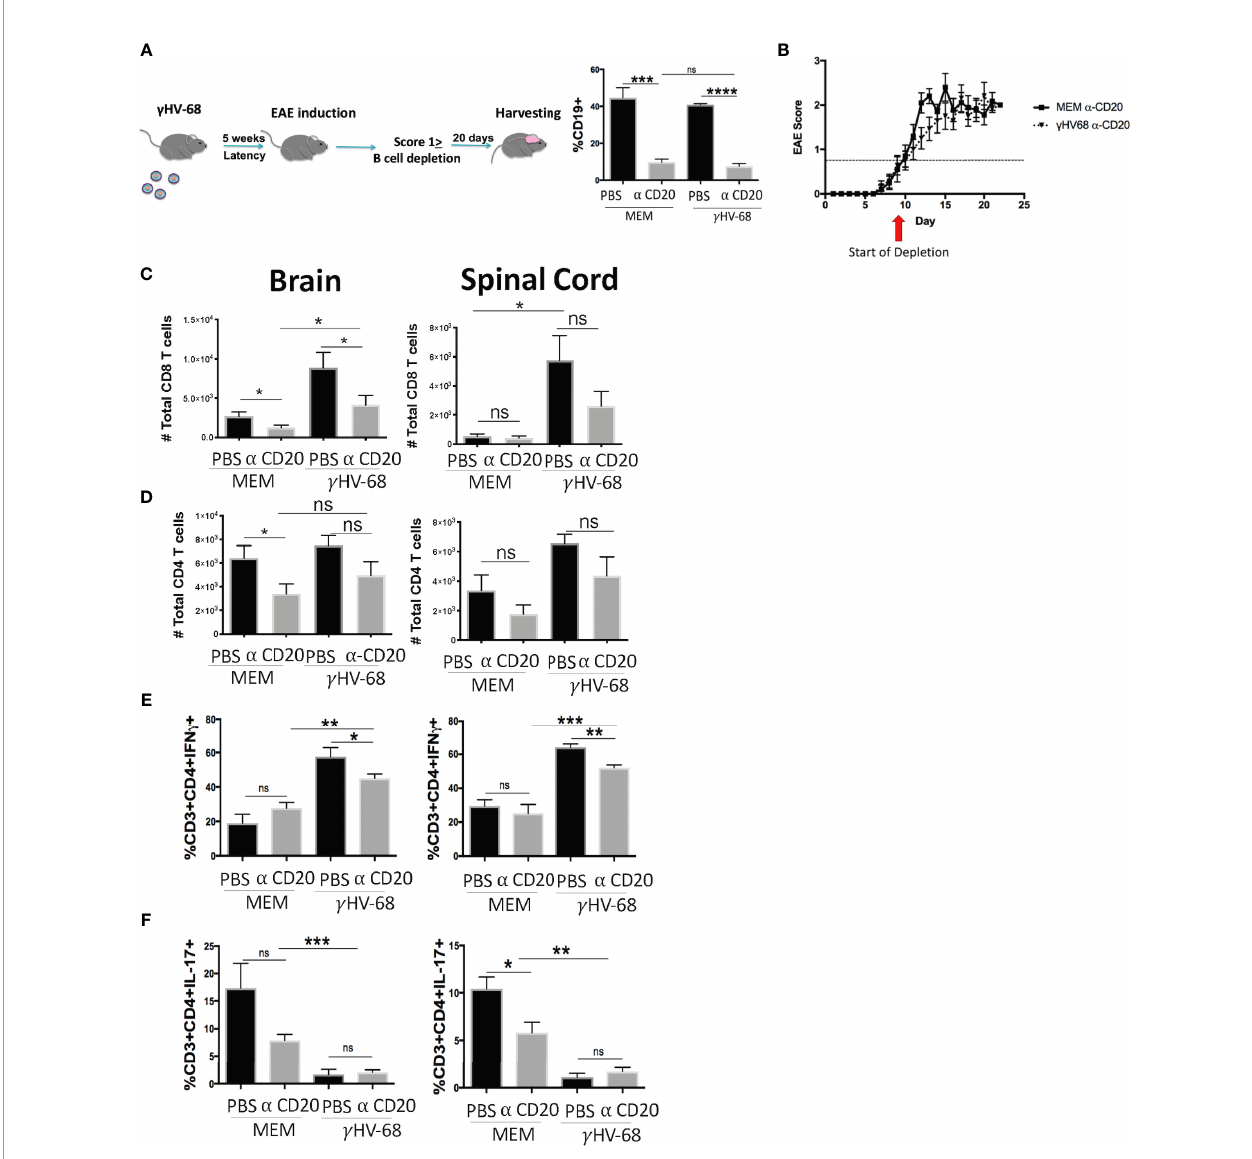
FIGURE 2 | Mice were infected with g HV-68 or MEM i.p. 5 weeks p.i. EAE was induced. When mice reached a score of ≥ 1 B cells were depleted with a -CD20 i.v. At days 20 to 22 post EAE induction, mice were perfused; brains, spinal cords were harvested and processed to isolate immune in fi ltrates. (A) B cell depletion work fl ow. Histogram shows a representative experiment of B population at moment of harvesting. (B) Graph shows EAE scores up to day 23 post induction. (C) Total CD8 + in fi ltrating cells in the brain and spinal cord. (D) Total CD4 + in fi ltrating cells in the brain and spinal cord. (E) Percentage of CD3 + CD4 + IFN g + . ( F) CD3 + CD4 + IL-17 + in the brain and spinal cord. Three independent experiments with 6 to 11 mice/group. Data analyzed with Student ’ s t-test: ***p < 0.001, **p < 0.01, *p < 0.05. ns = not signi fi